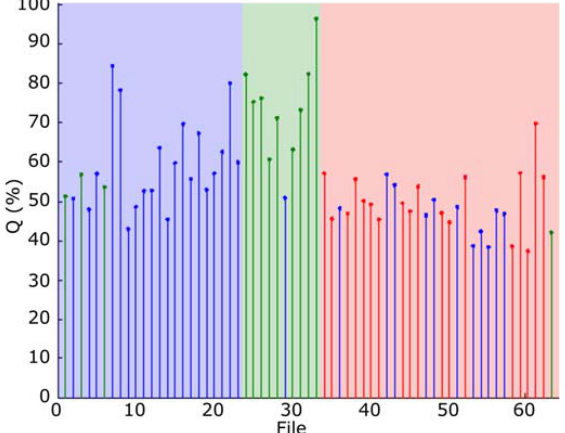
Figure 11. Classification result of all the samples of the audio collection.